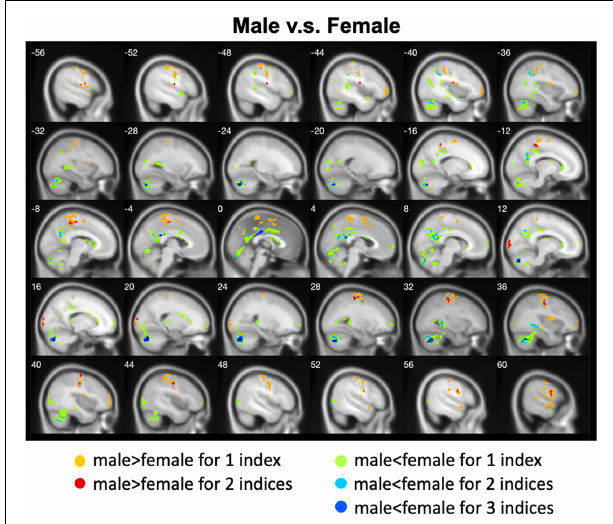
FIGURE 4 | Overlapped regions that showed different local spontaneous brain activity (i.e., ALFF, fALFF, and ReHo) between males and females. Light red indicates common regions for any two indices where the males exhibited significantly higher brain activity than the females. Light blue indicates the reverse. Dark blue indicates common regions for all the three indices where the females exhibited significantly higher brain activity than the males.